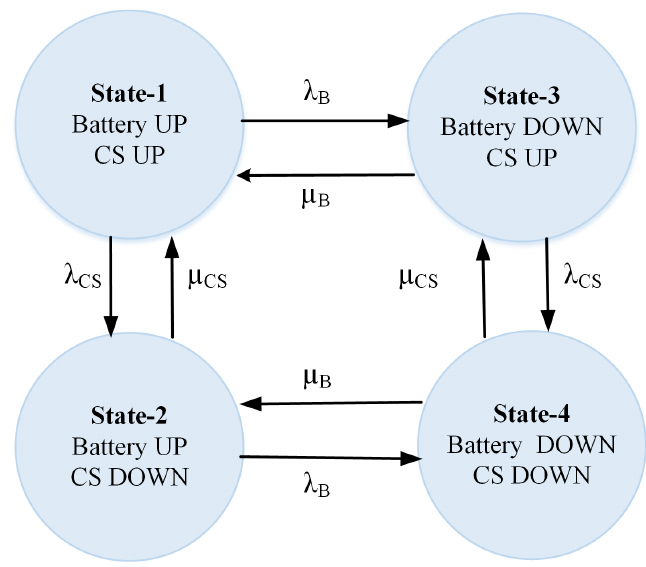
Figure 7. State-space diagram of the CS-Battery